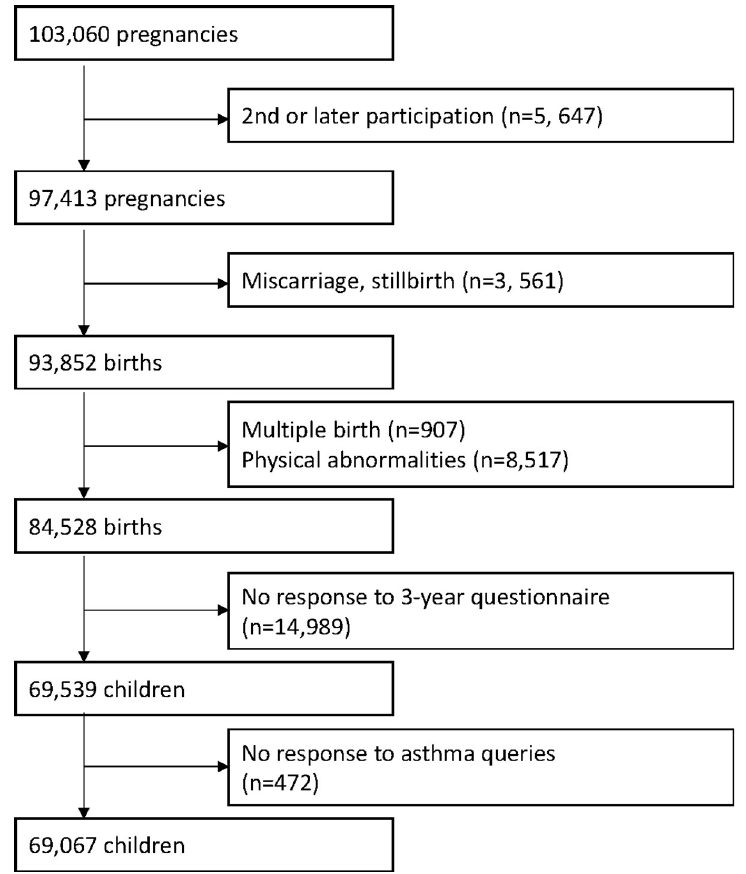
Fig 1. Flowchart of the